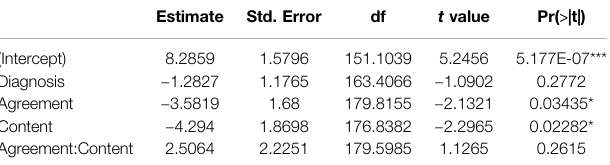
TABLE 8| Relative frequency ofresponsesmade bydepressed( N (cid:1) 15)and non- depressed participants ( N (cid:1) 45) in respect to their agreement (disagreeing or TABLE 6 | Coef fi cient table of the model used to probe the effect of depression agreeing) and content (sacri fi ce or diagnosis(Diagnosis; 0 (cid:1) nodepression diagnosis,1 (cid:1) depression diagnosis), content (Content; 0 (cid:1) sacri fi ce, 1 (cid:1) save), and agreement (Agreement; 0 (cid:1) disagreement, 1 (cid:1) agreement) on skin conductance rates during responsive utterances. The marginal R 2 for the model was 0.06 while the conditional R 2 was 0.15, indicating that the fi xed effects explained 6% of the variation. Estimate Std. Error df